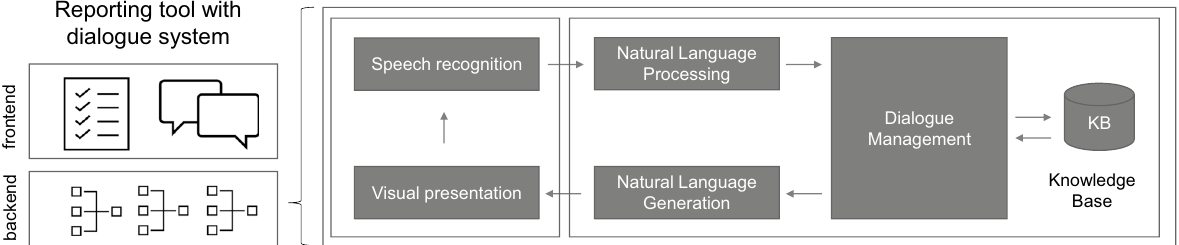
Fig. 4 Graphic representation of the reporting tool’s backend. The dialogue system comprises speech recognition, natural language processing (NLP), dialogue management with a knowledgebase, natural language generation (NLG), and visual presentation. The arrows represent the typical data flow. Speech recognition and visual presentation were built on top of indicda ® speech . NLP, dialogue management, knowledgebase, and NLG were built on top of Empolis Knowledge Express